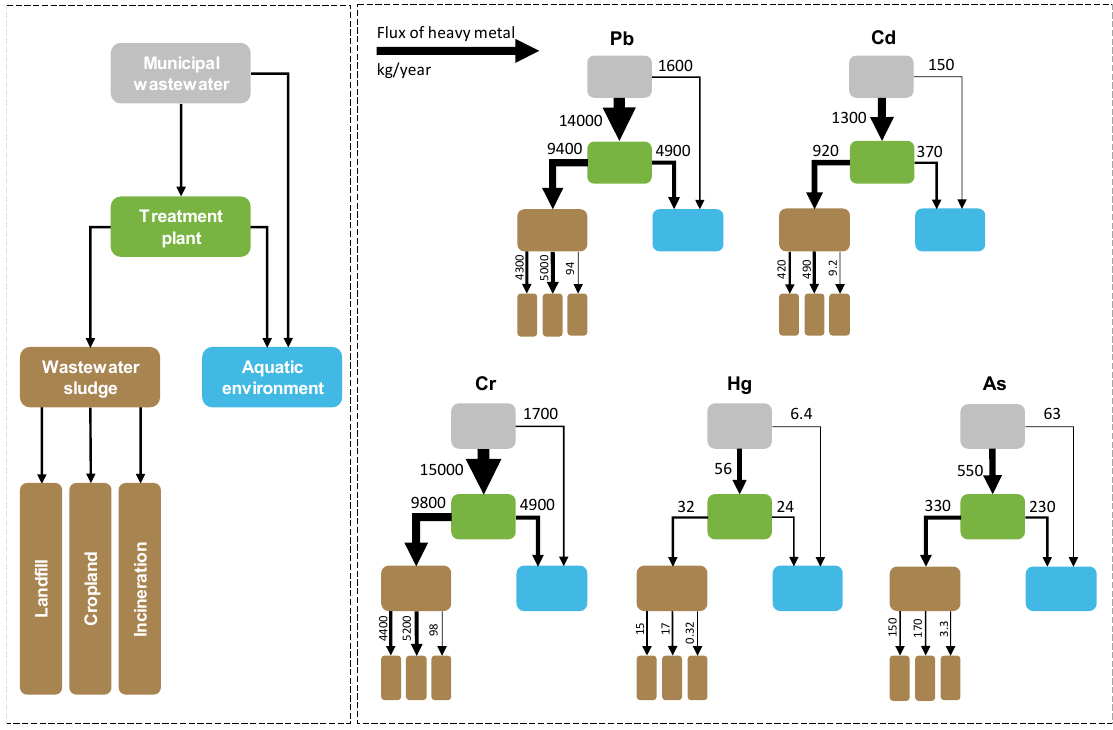
Figure 5. Material flow analysis of five heavy metals from municipal wastewater to sinks (the flow from municipal wastewater to treatment plant represents influent heavy metal of the wastewater treatment plant, while the flow from municipal wastewater to aquatic environment represents the metal discharged from untreated wastewater to aquatic environment directly).